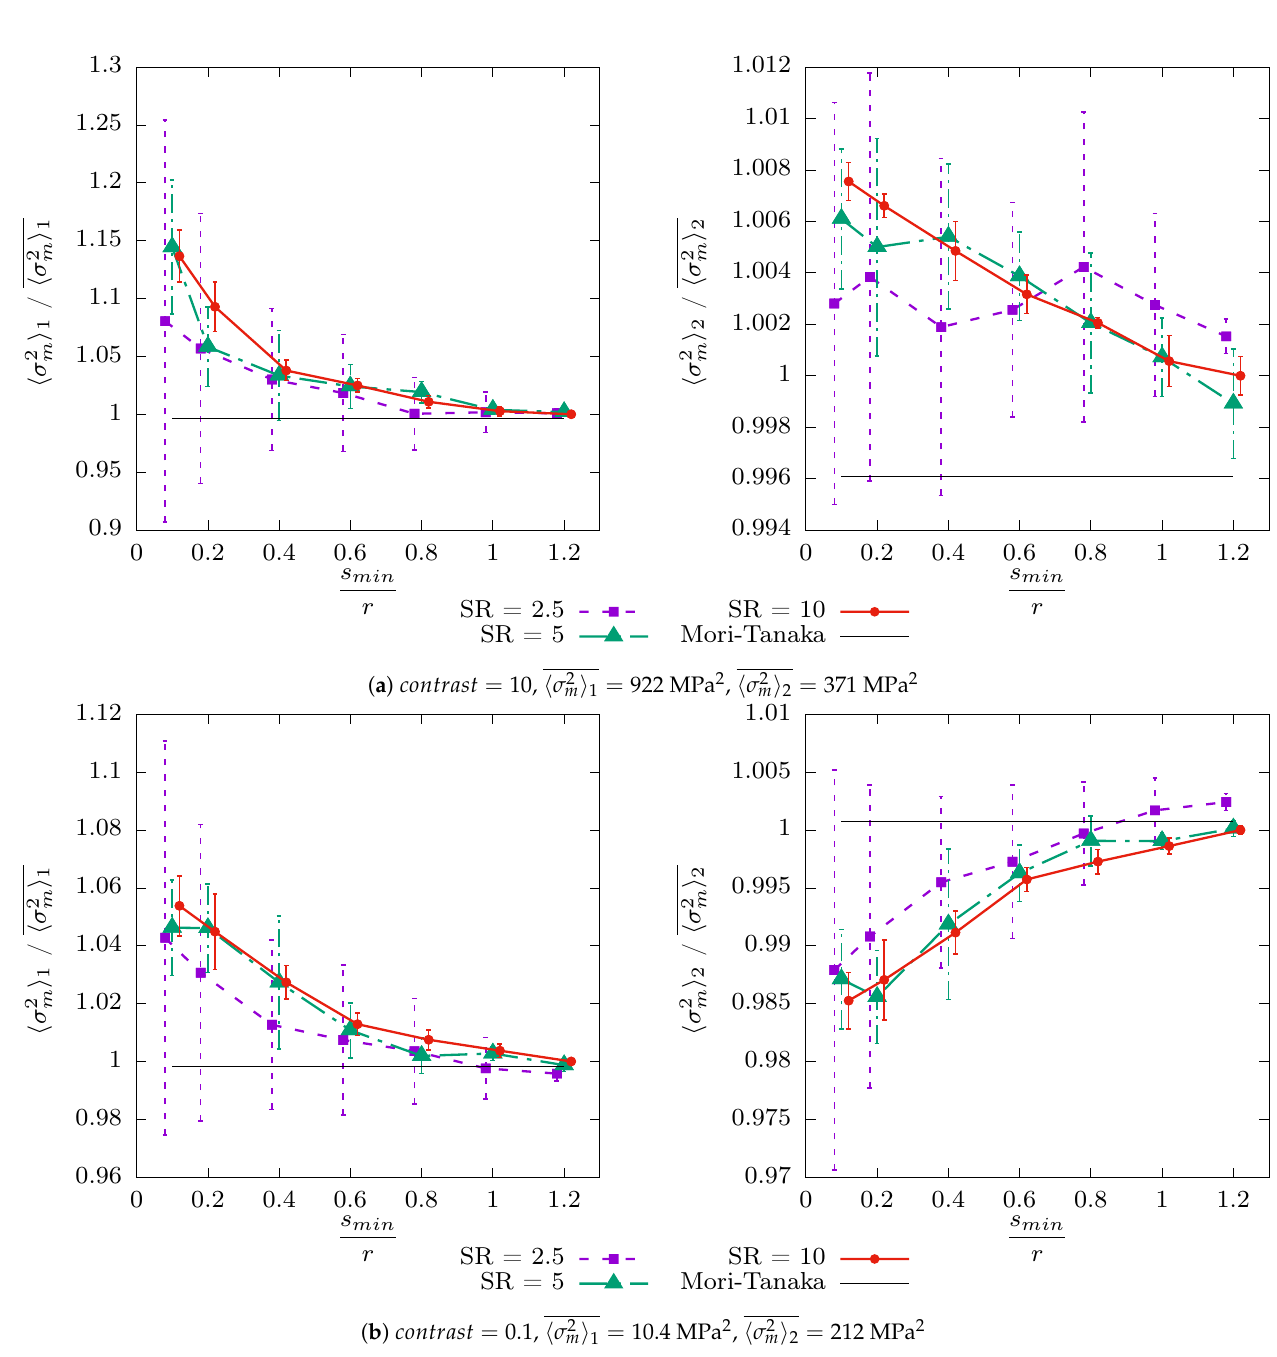
Figure A6. Mean values and standard deviations on the mean value for the second moment of hydrostatic stress by phase as a function of the packing parameter s min / r ( r = 10 µ m) for a volume fraction of inclusions f v = 13.4 %. For clarity, the error bars and dots are slightly shifted around for each studied minimum